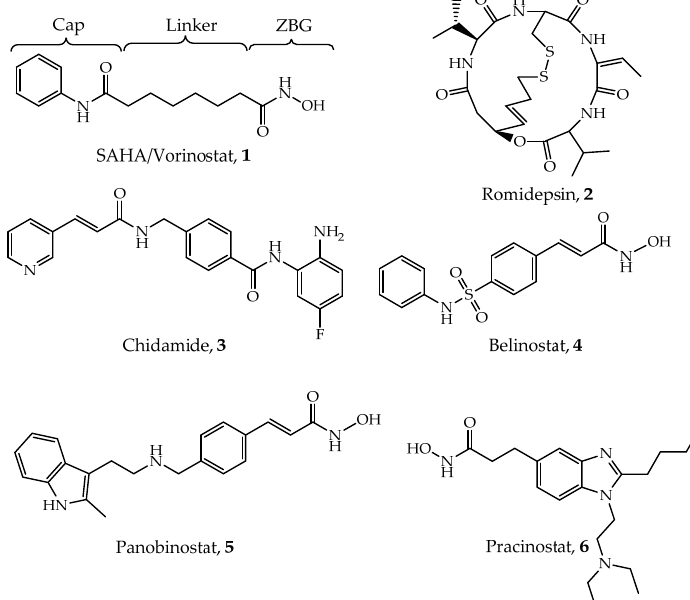
Figure 1. Structures of Food and Drug Administration (FDA)-approved Class I histone deacetylases (HDAC) inhibitors.